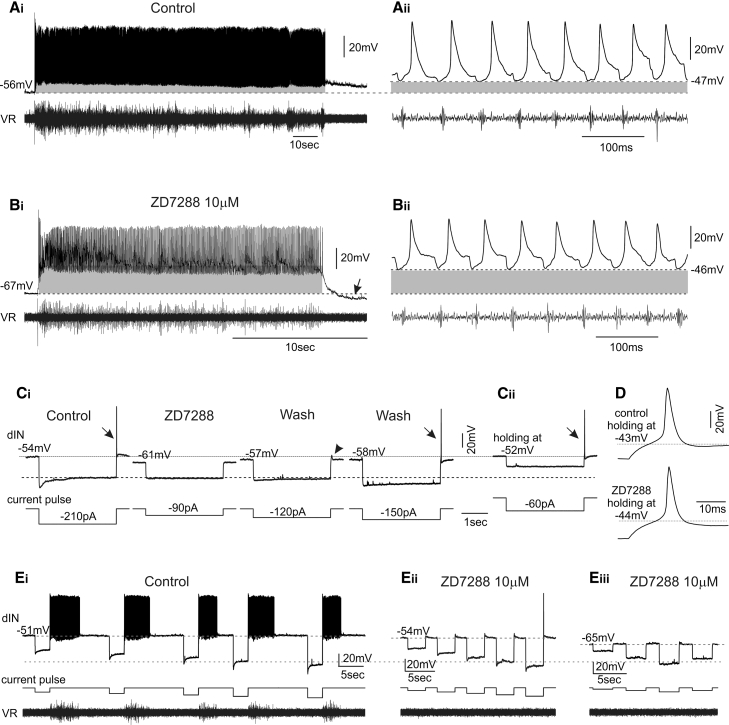
Blocking Ih Currents Alters dIN Firing during Swimming and Affects Rhythm Initiation(A) Example of a dIN firing during swimming.(B) In the presence of ZD7288, the tonic depolarization indicated by the gray area is larger and dINs fire at a more depolarized level. Note the different timescales in (Ai) and (Bi) and the shorter episode duration in the presence of ZD7288. The action potentials shown in (Bii) are smaller than those in (Aii). Arrow indicates a membrane hyperpolarization following the end of the swimming episode.(C) Membrane responses to (Ci) current pulses in control, in the presence of the Ih blocker ZD7288 (10 μM), and in wash. ZD7288 abolished both the sag currents and the PIR action potentials (arrow). Its effect could be partially reversed after a long wash. The post-inhibitory depolarization seen in control disappeared in the presence of ZD7288 and re-appeared during wash (arrow head). (Cii) In the presence of ZD7288, the PIR action potential could be induced when holding RMP to the control level by current injection.(D) The rebound action potential shapes in control condition and in ZD7288.(E) In some dINs (n = 3), (Ei) a single rebound action potential induced by a hyperpolarizing pulse initiated fictive swimming activity (note ventral root [VR] activity). (Eii) The property shown in (Ei) was abolished soon after ZD7288 was applied (approx. 10 min after drug application; n = 3), although PIR firing could still be evoked and the sag potential is only partially blocked. (Eiii) Later in ZD7288 treatment, both the PIR firing and the sag potential were totally abolished.